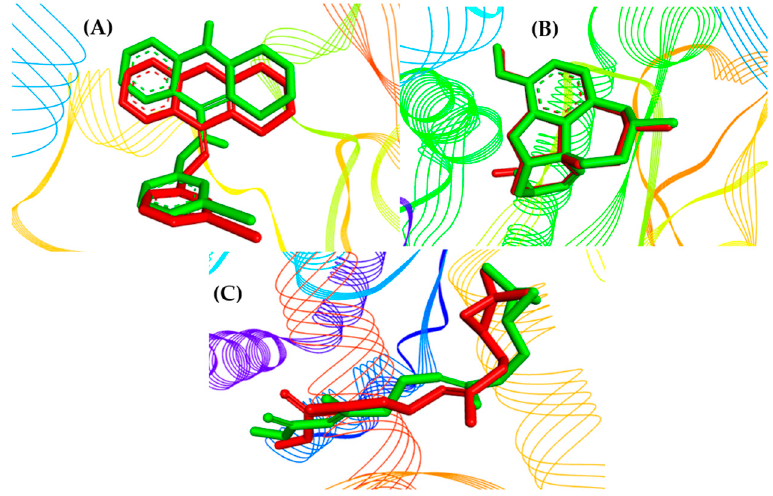
Figure 3. Superpositions of crystallographic ligands poses (in green) with the calculated poses (in red): ( A ) I40, ( B ) GNT, and ( C ) JHIII.